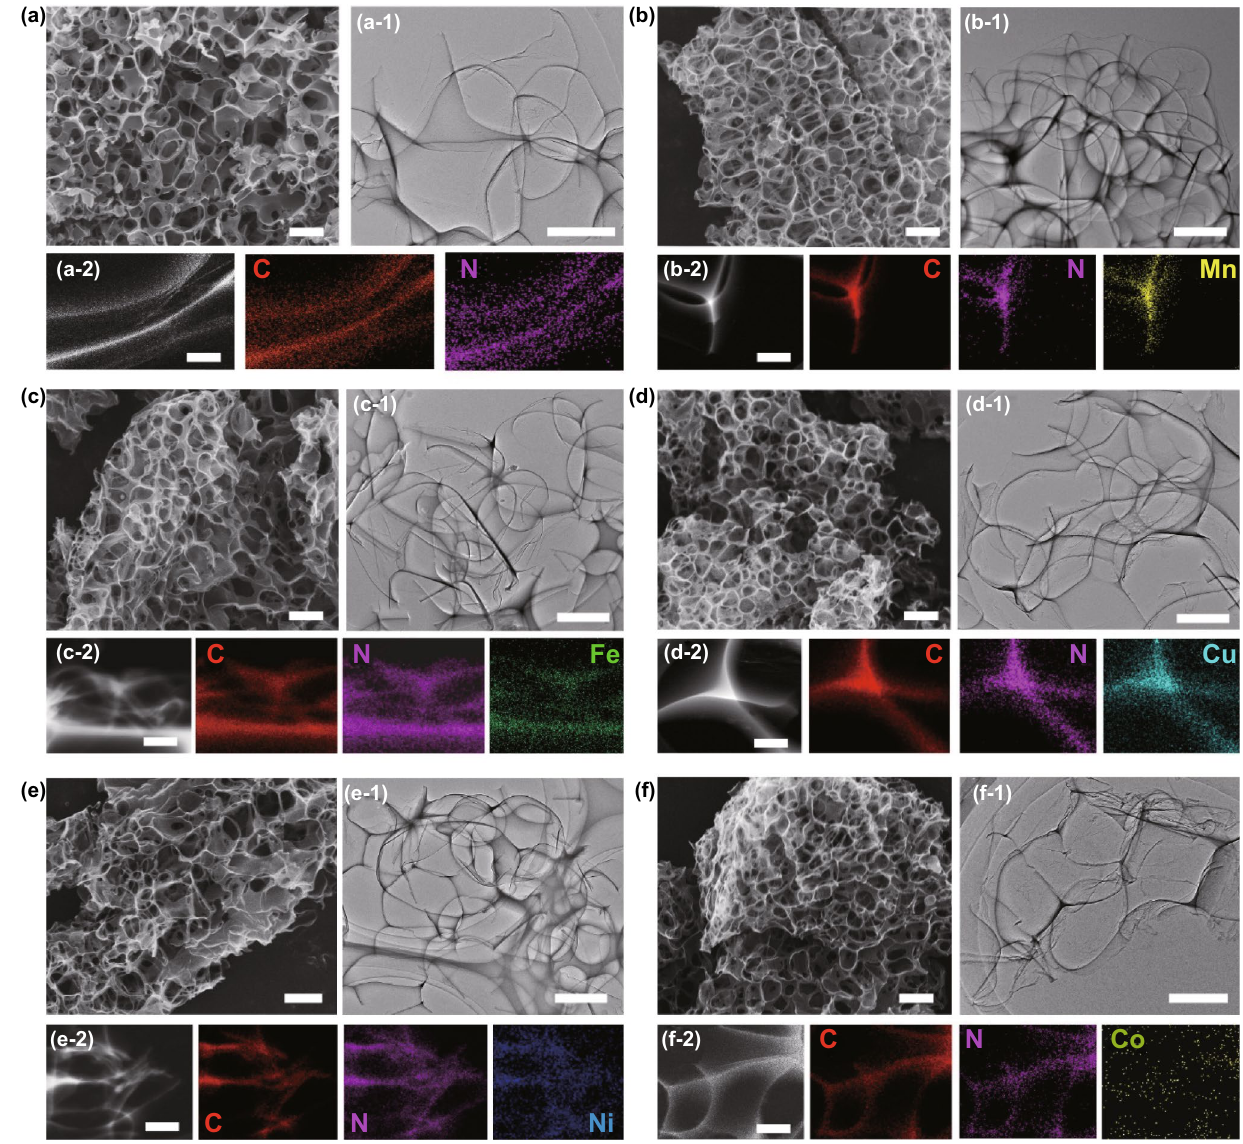
Fig. 2 SEM images, TEM images, and EDX mapping of a 3D NC, b 3D Mn–NC, c 3D Fe–NC, d 3D Cu–NC, e 3D Ni–NC, and f 3D Co–NC. Scale bars: a–f 1 μm; a1–f1 500 nm; a2–f2 200